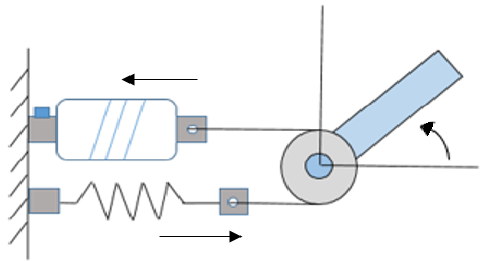
Figure 5. Schematic diagram of the drive of robotic arm (1st axis).